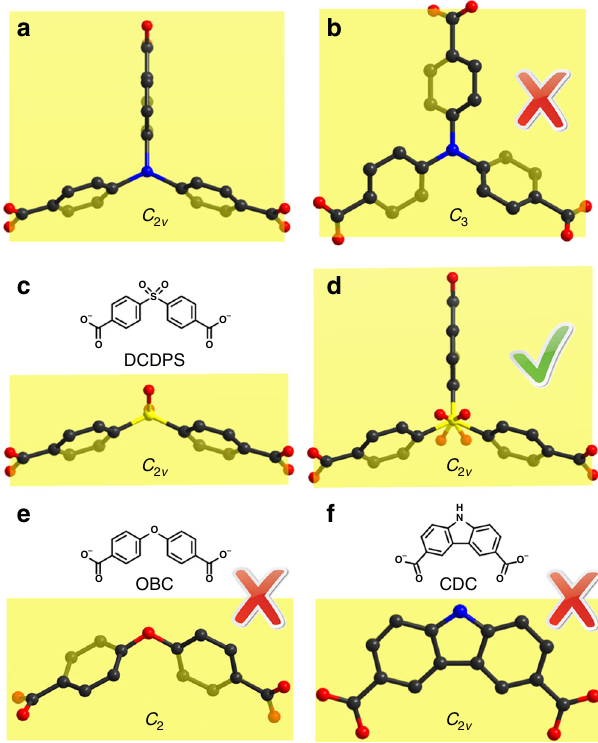
Fig. 4 Geometries of ligands. a TPA conformation in the proposed structure, b TPA conformation in its free state, c DCDPS conformation in its free state, d disordered DCDPS linker, e and f conformation and symmetry of OBC and